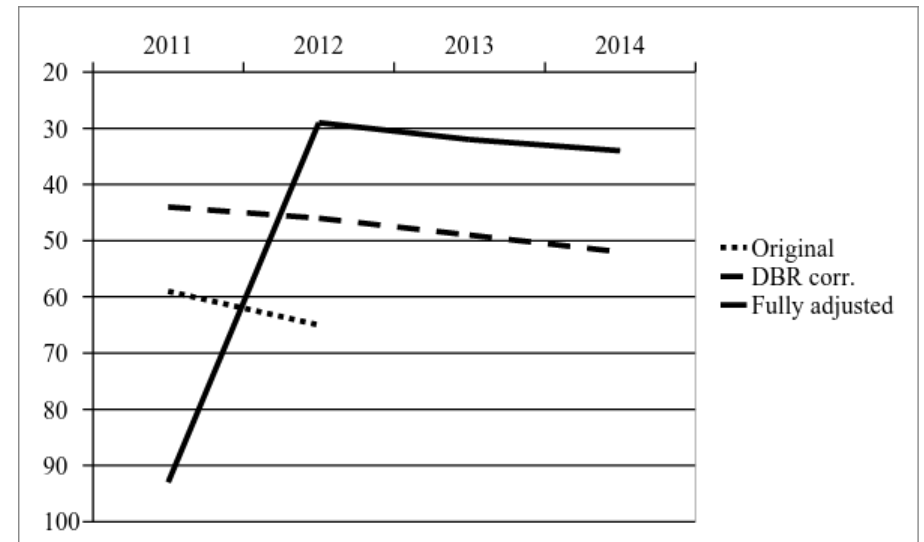
Graphic: adjusted rankings for Italy (Protecting Investors